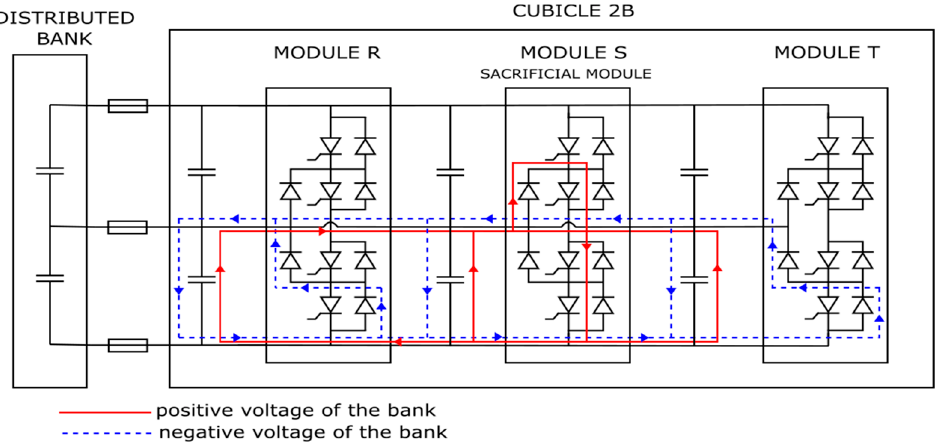
Figure 12. Current distribution in the faulty inverter during the fault. The updated model was used to analyze the fault evolution after the fuse intervention in order to justify the damage in the components observed after the test. The fuse